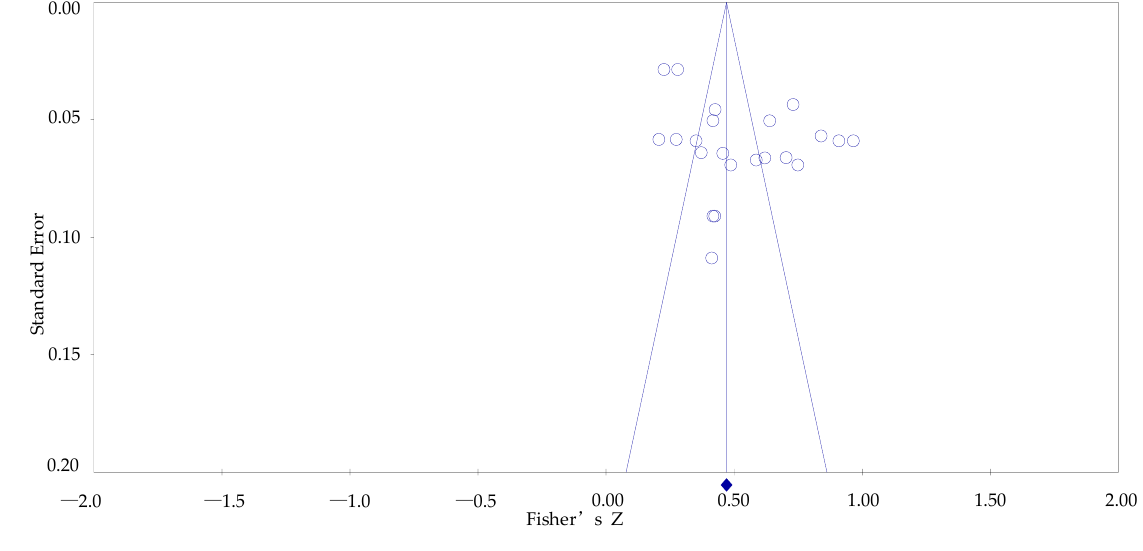
Figure 4. Total sample funnel chart. Table 3. Bias